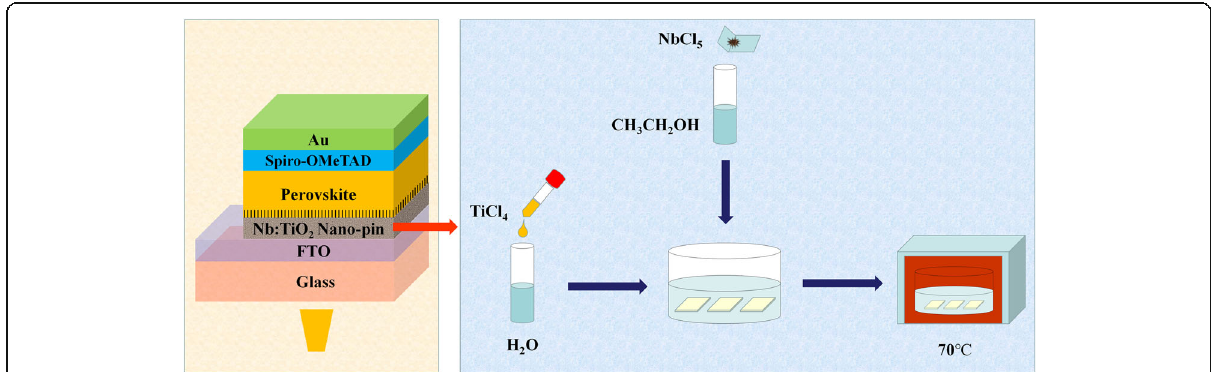
Fig. 1 Schematic of PSC structure and Nb:TiO 2 synthesis procedure